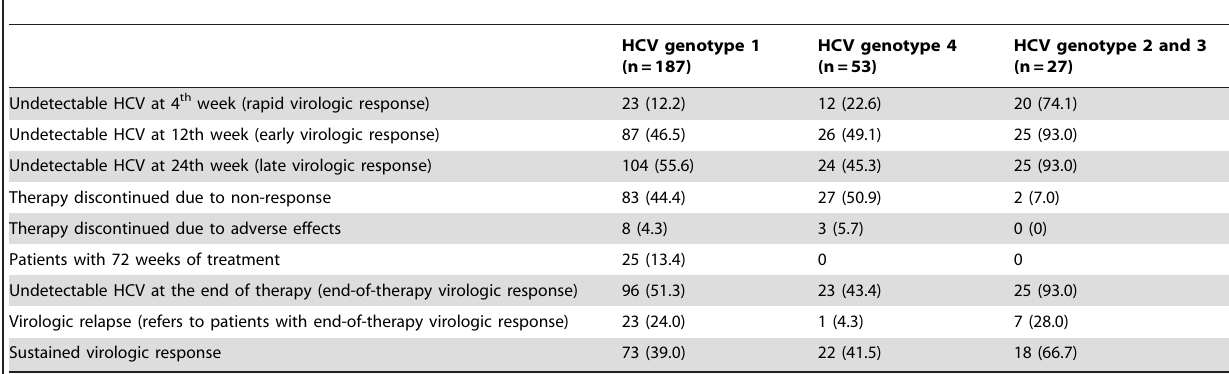
Table 1. Response to pegylated interferon- a 2a plus ribavirin of 267 HIV/HCV coinfected patients, grouped as a function of HCV